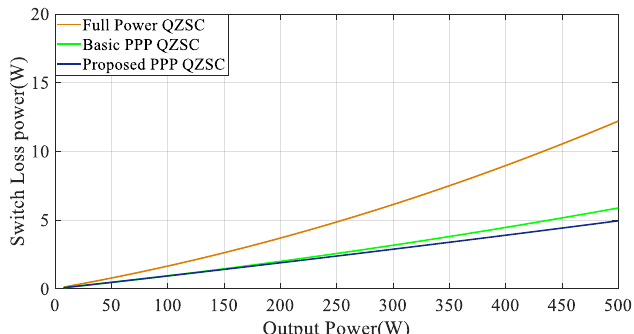
Figure 9. Switch power loss versus output power for the three discussed converters.